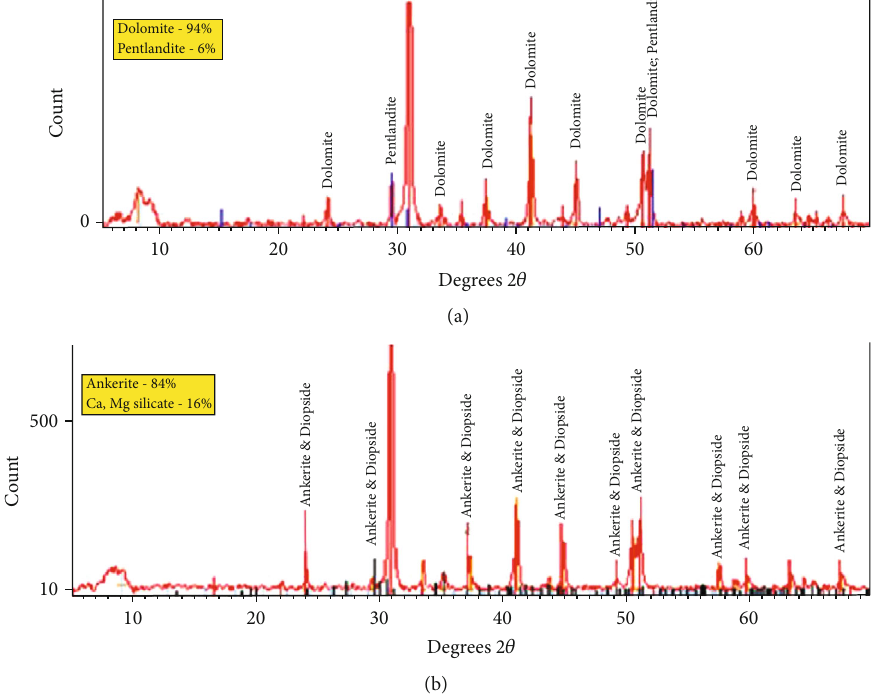
Figure 7: X-ray di ff ractograms showing di ff erent mineral constituents within the studied carbonate succession. The major minerals observed are dolomite and some other minor constituents (i.e., pentlandite, ankerite, and diopside) in the studied samples. The presence of high- temperature minerals shows the emplacement of igneous activity.